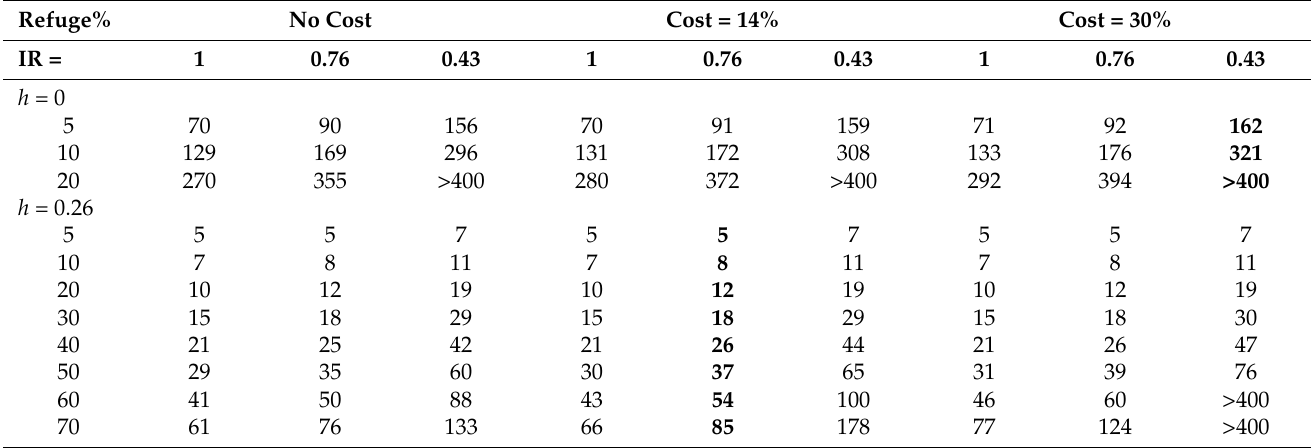
Table 4. Simulated effects of cost and incomplete resistance (IR) on evolution of resistance. Inheritance of resistance was recessive ( h = 0) or nonrecessive ( h = 0.26). For each value of a recessive cost (0, 14, or 30%), IR was 1, 0.76, or 0.43, respectively. For each combination of parameter values, we report the number of generations for the resistance allele frequency to increase from its initial value of 0.001 to more than 0.50. Results in bold correspond to cases of pests without practical resistance ( h = 0, cost = 30%, IR = 0.43) and with practical resistance ( h = 0.26, cost = 14 %, IR =